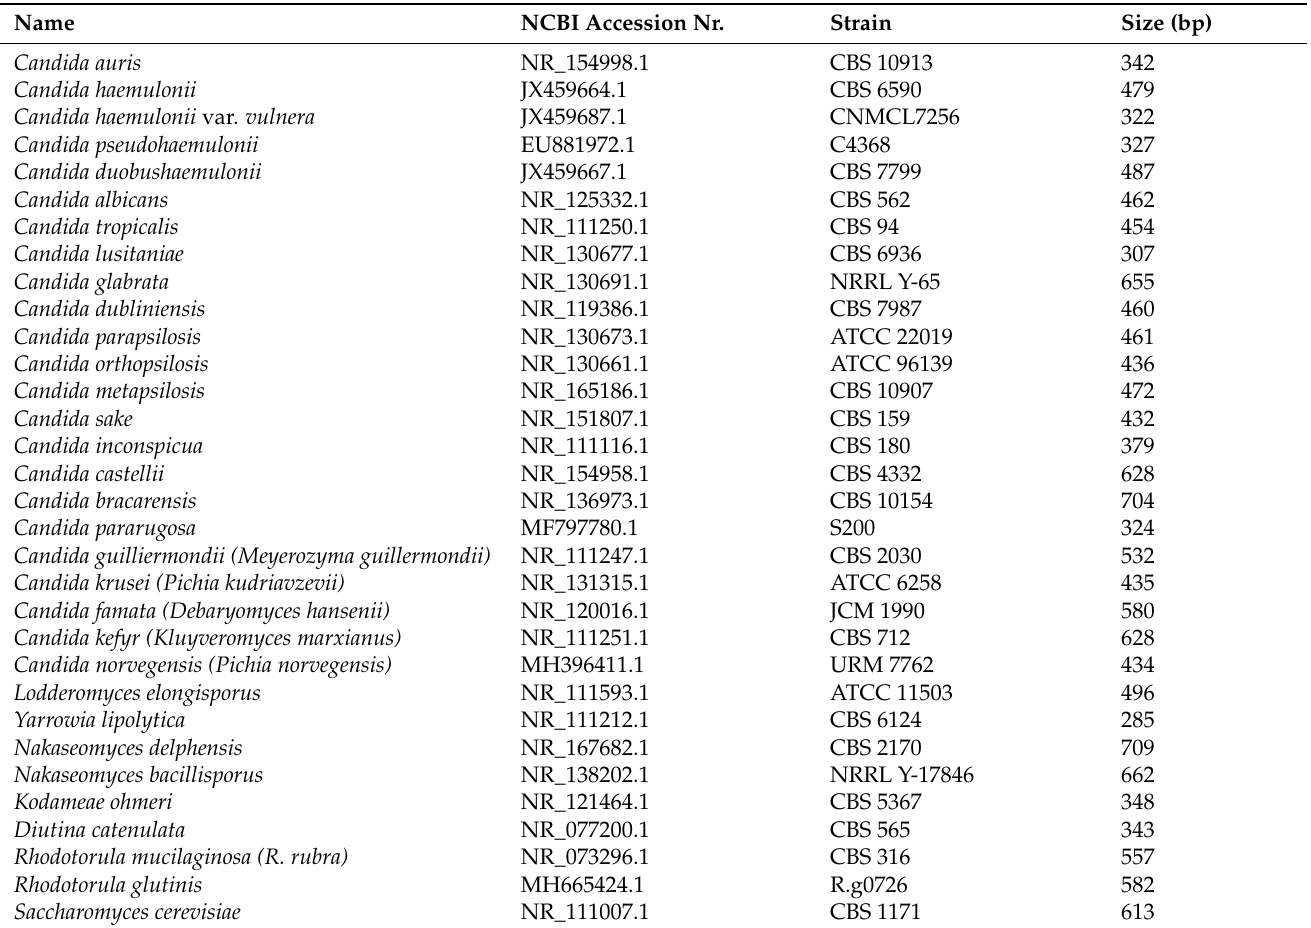
Table A1. All species included in the alignment to identify a C. auris -specific ITS region for the design of primer ITS_Cau_R. The species and strain names are given, along with the ITS sequence NCBI GenBank accession and the size of the sequence in the alignment after